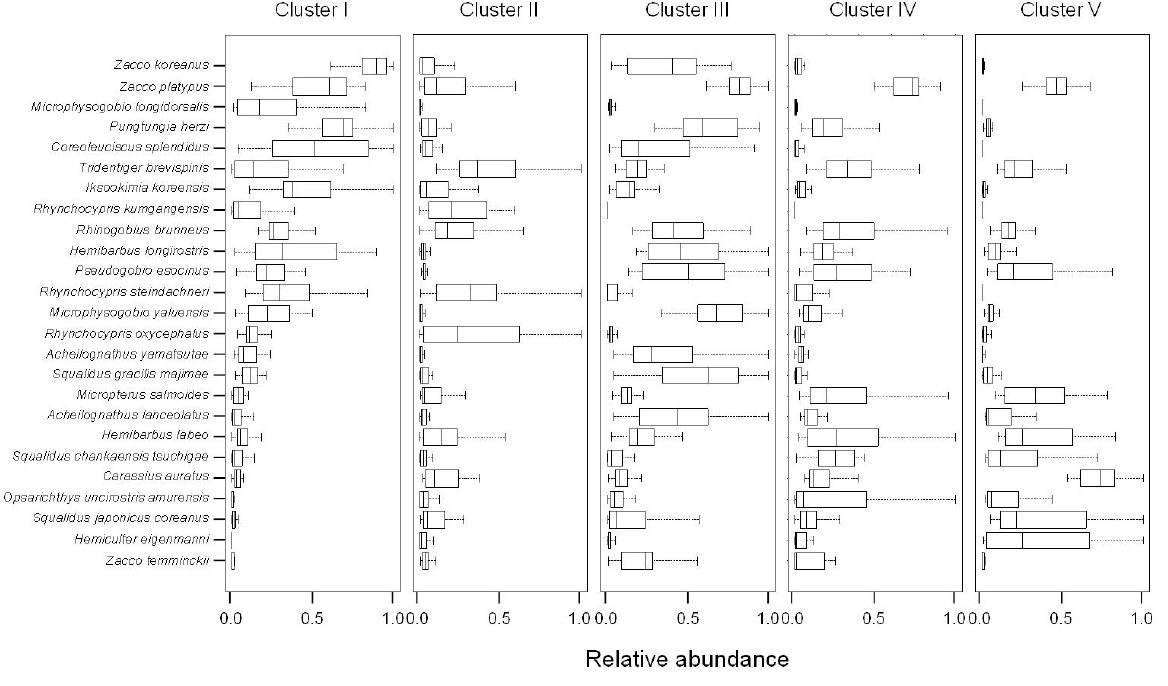
Figure 6. Relative abundance of 25 dominant species in difference clusters. Values were obtained from weight vectors of the trained self-organizing map (SOM) (boxplot: - median, 25-75% percentiles, non-outlier range).